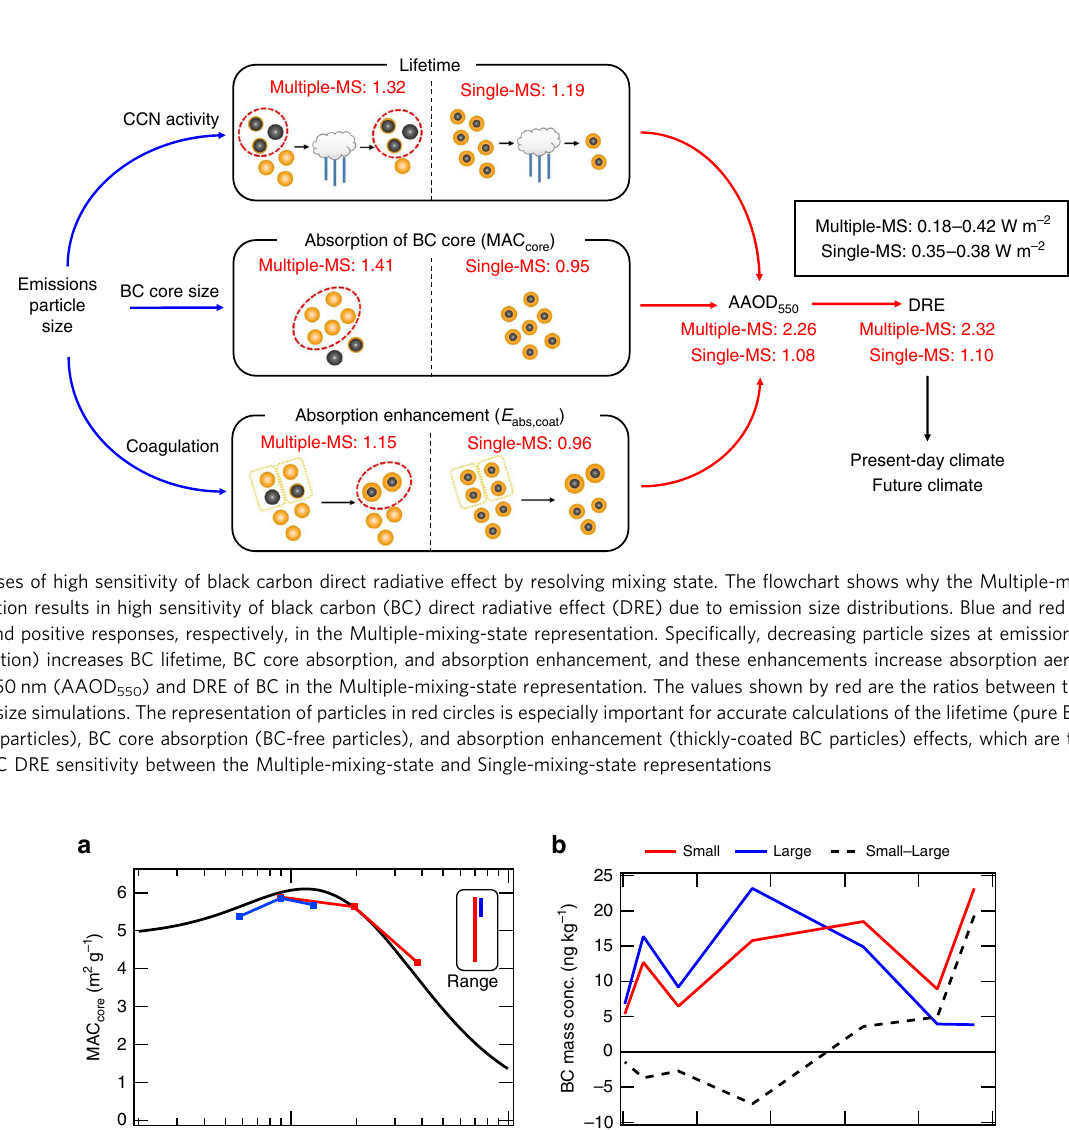
than the Large-size simulation (Fig. 5b). These thickly-coated BC particles are mainly produced by coagulation 22 , which is faster in the Small-size simulation compared to the Large-size simulation because total aerosol number concentrations are higher (i.e., more smaller particles) and hence the rate of coagulation is faster. Since thickly-coated BC particles have a higher absorption enhancement compared to thinly-coated BC particles, absorption enhancement in the Small-size simulation